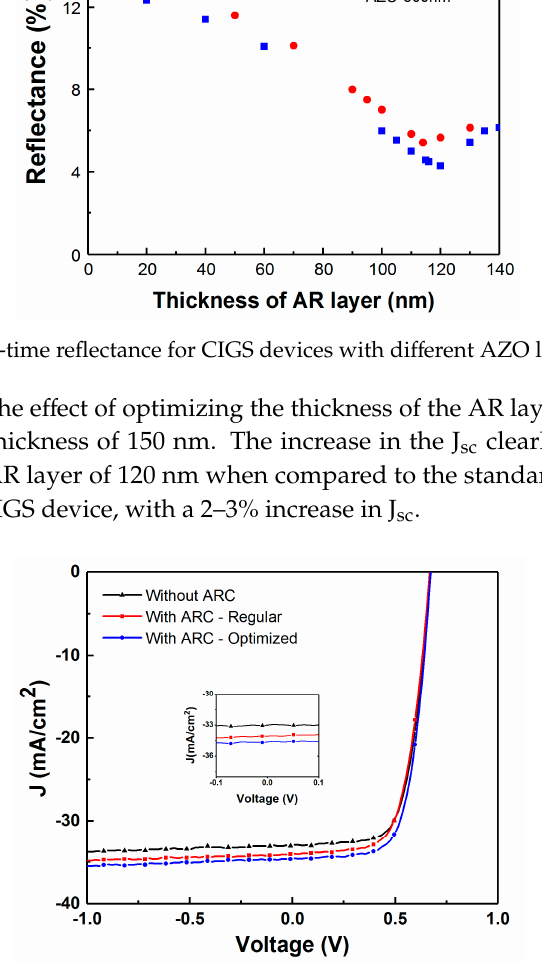
Figure 15. Comparison of the effect of optimized ARC on measured J–V curves for CIGS solar cells with a 150 nm thick AZO layer and either no AR coating, a 105 nm prior modeled AR coating thickness, or a 120 nm in-situ optimized AR coating thickness (insert: close up of the − 0.1 V to 0.1 V zone).